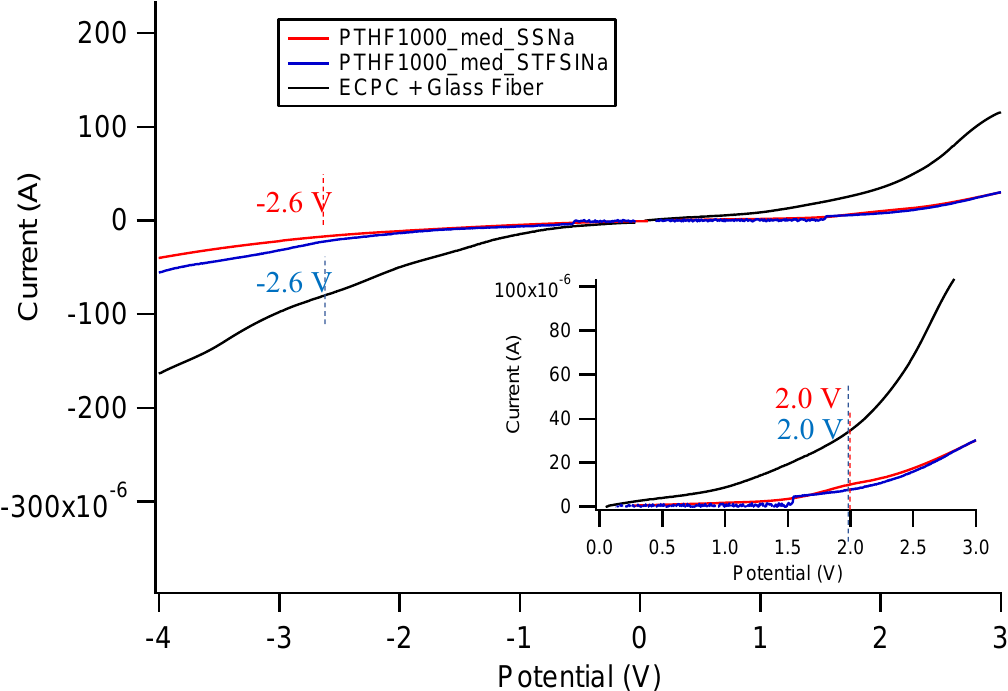
Figure A35. Oxidative and reductive stability of EC/PC and EC/PC gelled Na exchanged SIPEs. Configuration is stainless steel/Pt. Table A2. Electrochemical stability window for tested SIPEs. Configuration is stainless steel/Pt.